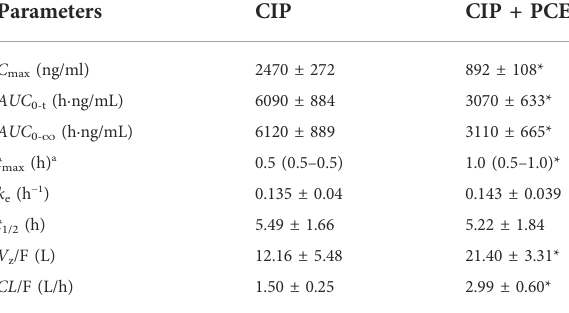
TABLE 3 Pharmacokinetic parameters of cipro fl oxacin after intragastric administration of cipro fl oxacin (CIP, 0.045 g/kg) with and without PCE (0.72 g/kg) to rats (mean ± SD, n =